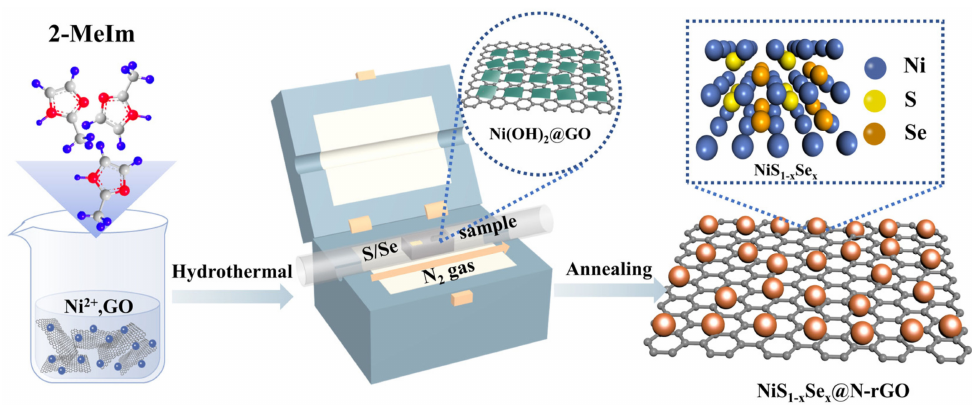
Figure 1. Schematic process of the formation of NiS 1 − x Se x @N–rGO